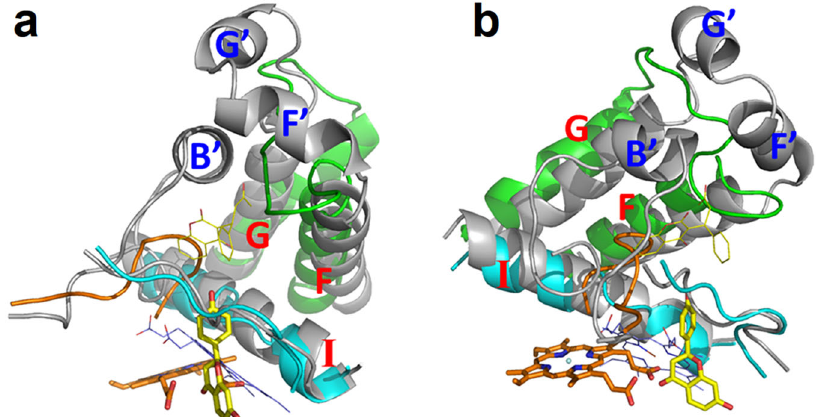
Fig. 5 Conformation of the entrance to the 2-HIS active site. The conformation is shown in two different orientations with the plane of the heme ring perpendicular to the paper and the heme propionate groups pointing to the front ( a ) and with the heme propionate groups pointing to the right ( b ). The structure of 2-HIS is illustrated using different colors: the B-C loop (orange), helices F and G and F-G loop (green), helix I and strand β 1-4 (cyan); and human P450 2C9 is in grey. The substrate and heme in 2-HIS are shown as thick bond models in yellow and orange, respectively, and the substrate and heme (thin bond model) in human P450 2C9 are in yellow and blue,